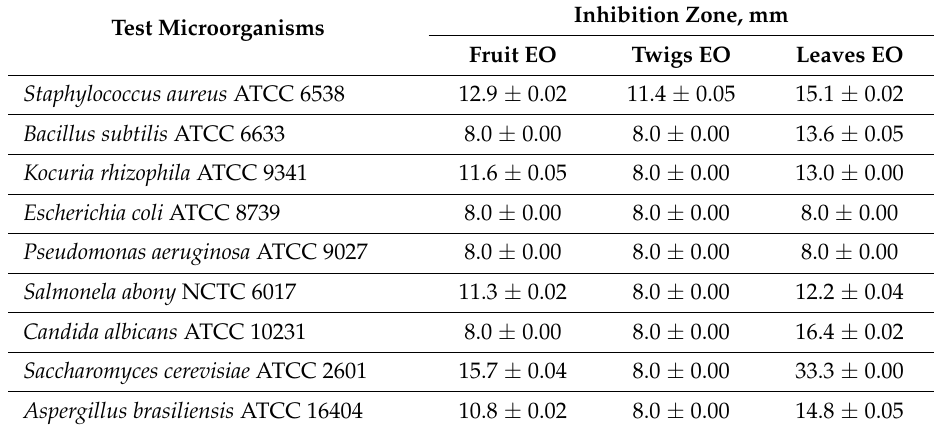
Table 2. Antimicrobial activity of laurel ( Laurus nobilis L.) fruits, twigs, and leaves essential oil (EO). Inhibition Zone, mm Test Microorganisms Fruit EO Twigs EO Leaves EO Staphylococcus aureus ATCC